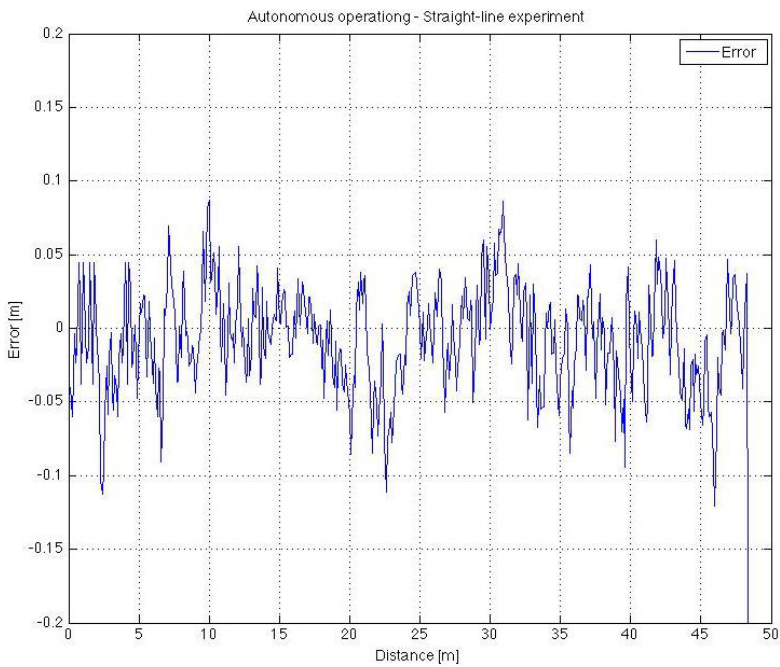
Figure 10. Physical